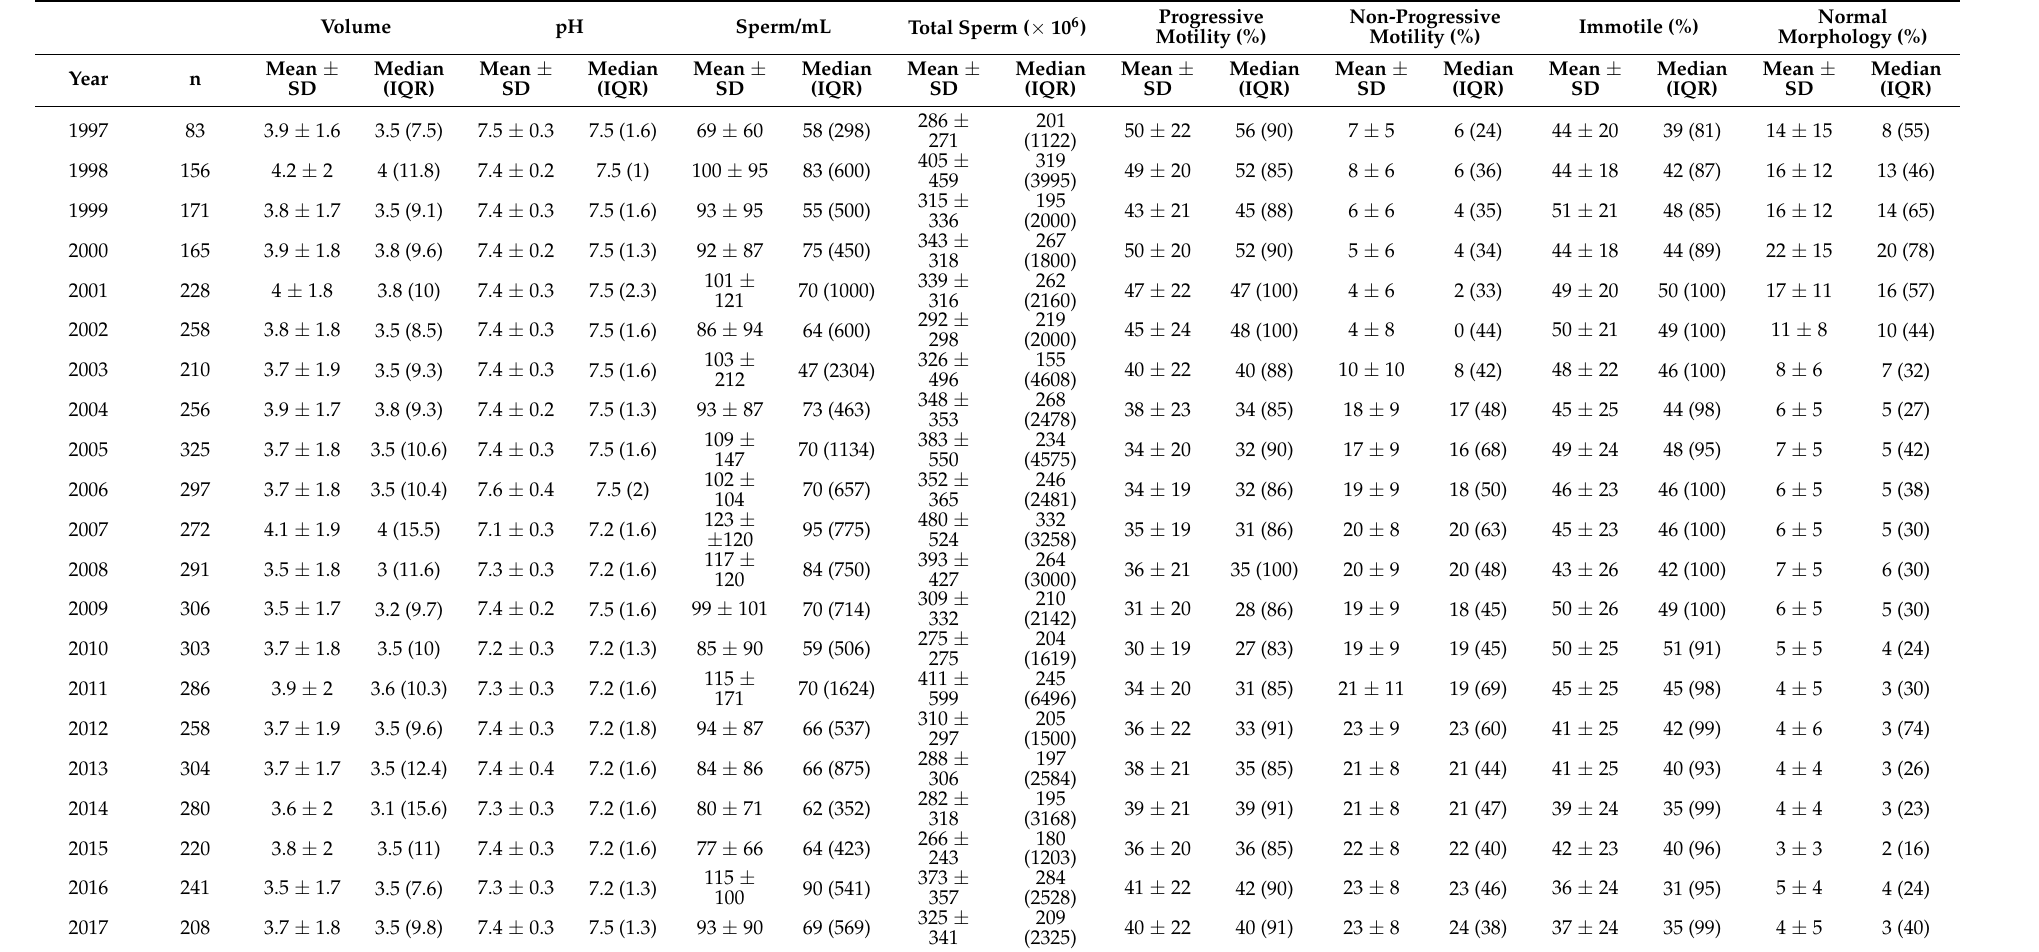
Table 1. Semen parameters of the samples included in the study divided by